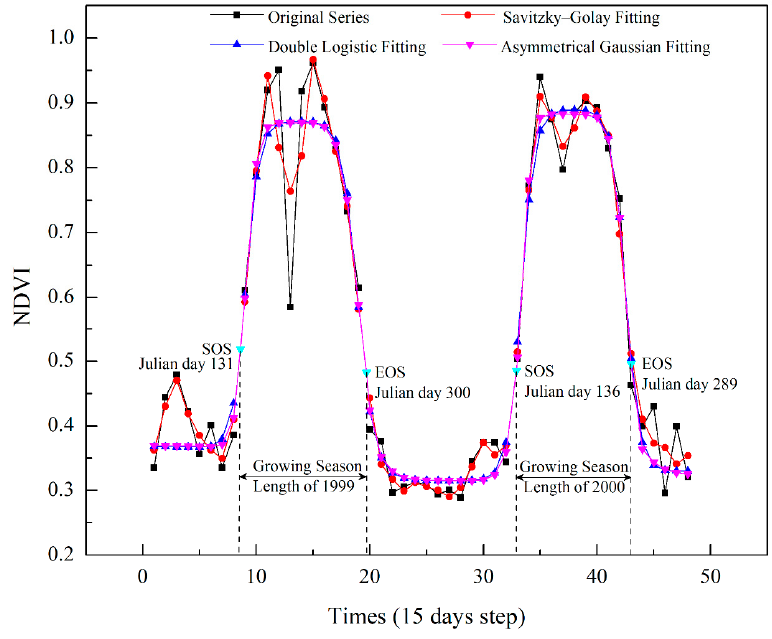
Figure 3. Time series reconstruction for NDVI using three functions. Displayed SOS and EOS estimates were calculated by combining the asymmetrical Gaussian function with dynamic threshold method. Table 2. Root mean square error (RMSE), Akaike Information Criterion (AIC), and Bayesian Information Criterion (BIC) based assessment of the DL and AG fitting methods (best-fitting method shown in bold).